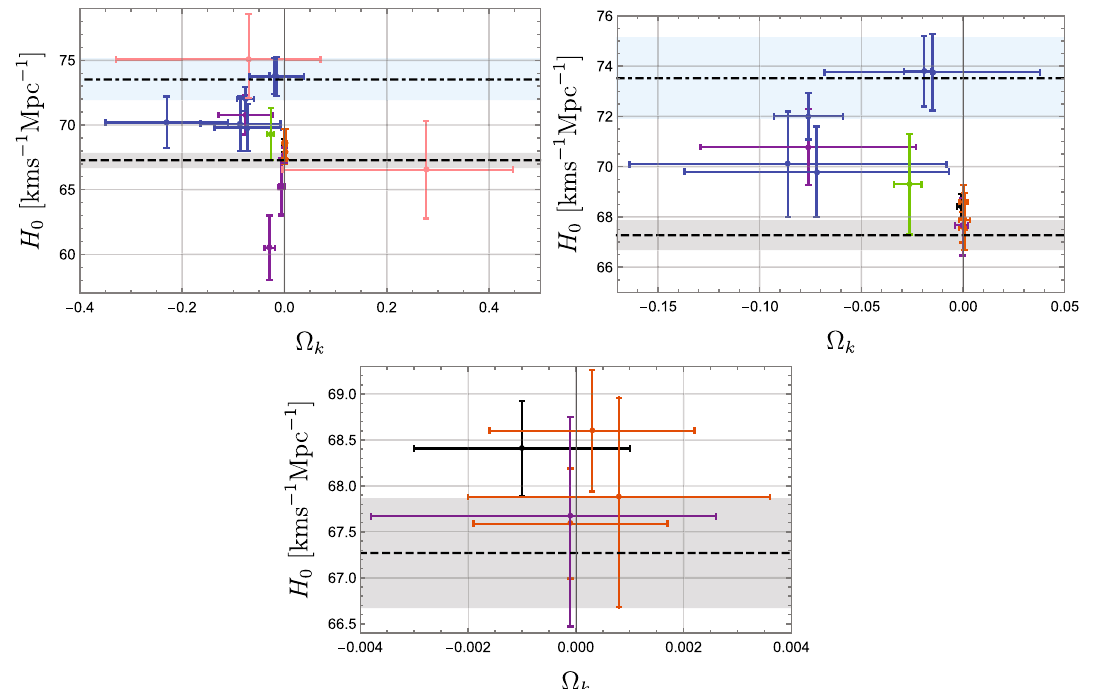
Fig. 5 Combined plots of the constraints on H 0 vs. (cid:2) k for the mea- surements in Fig. 2 and Fig. 3, based on (k)LCDM scenario. The com- panion data in Figs. 2 and 3 has the same color. The grey and blue vertical bands correspond the value of Planck 2018, H 0 = 67 . 27 ± 0 . 60 km s − 1 Mpc − 1 [32], and the local measurement using Cepheids, H 0 = 73 . 52 ± 1 . 62 km s − 1 Mpc − 1 [6], respectively, as in Figs. 2 and 3. By excluding some anomalous cases (top and rightmost oranges; left-